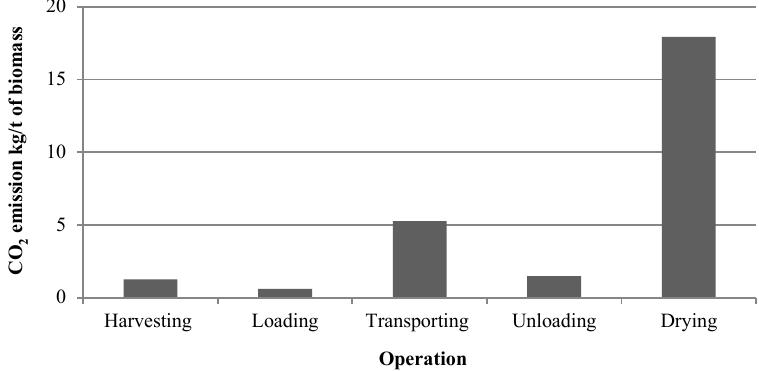
Fig. 6. The structure of CO 2 emission from fossil fuel (Technology